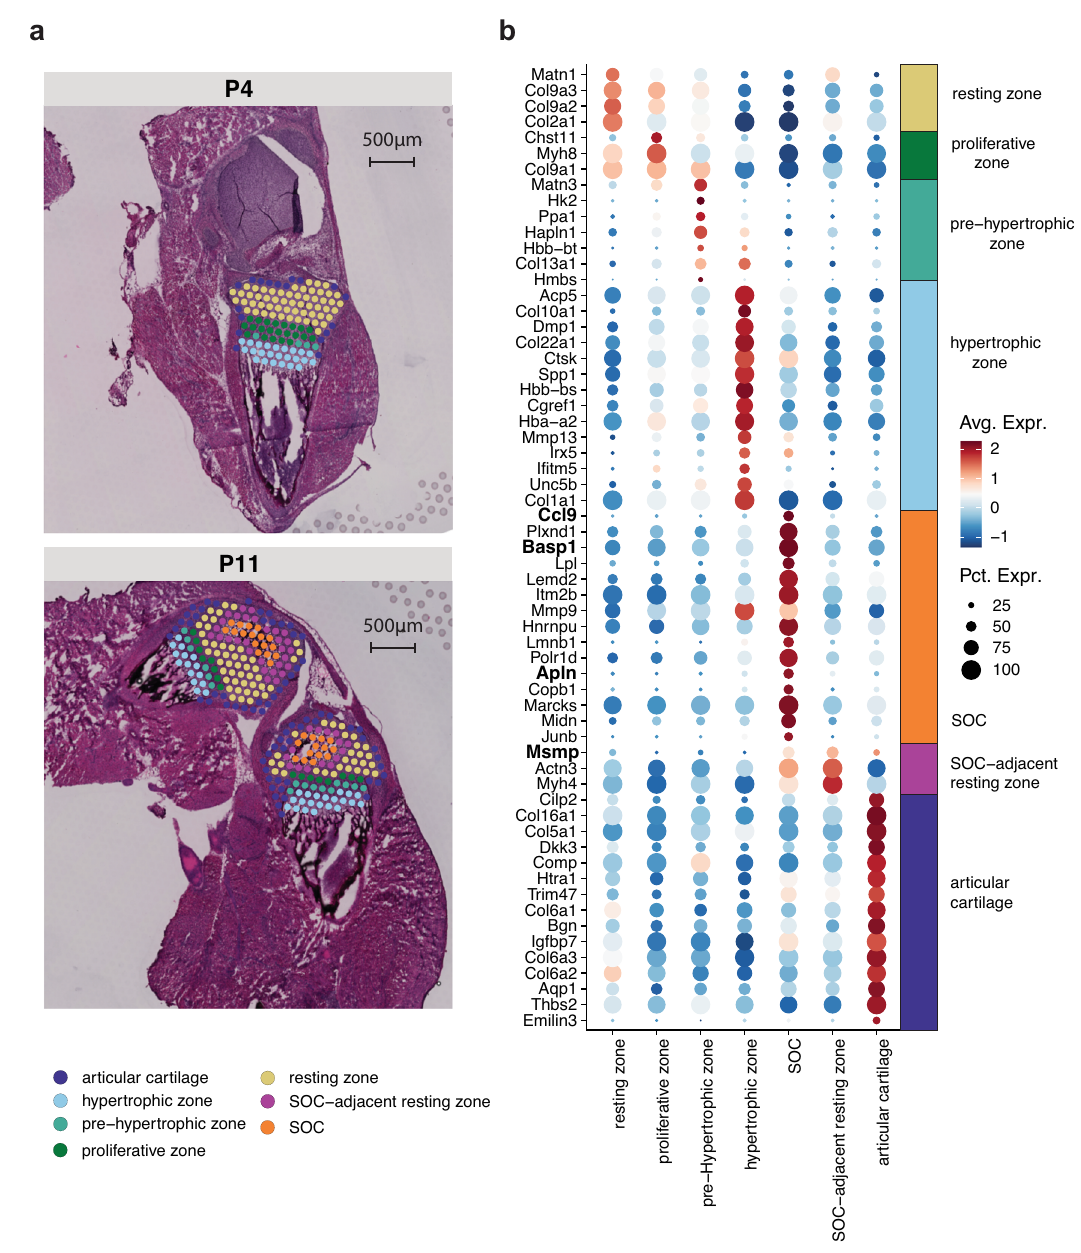
Fig.7|Investigatingthepotentialsecretedmarkerswithinmousecartilageat2 postnatal time points. a Comparing the manually assigned sub-clusters between postnatalday4andday11. b Differentiallyupregulatedgeneslistedfromhighestto